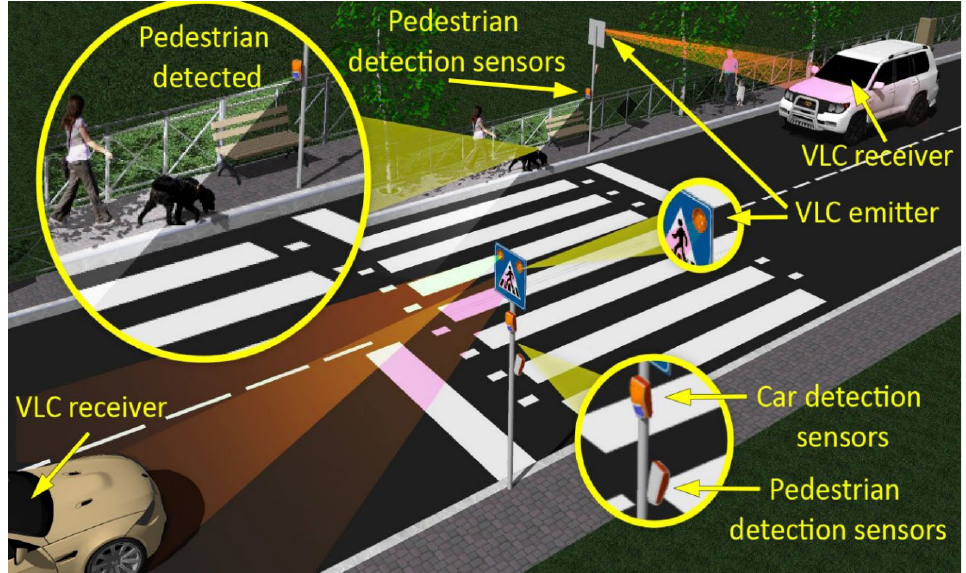
Figure 2. Functionality of the envisioned architecture: based on localization sensors, the intelligent crosswalk is able to identify pedestrians that might use the crosswalk; these data are then transmitted by the LED traffic sign toward the approaching vehicles by using the visible light communications technology.